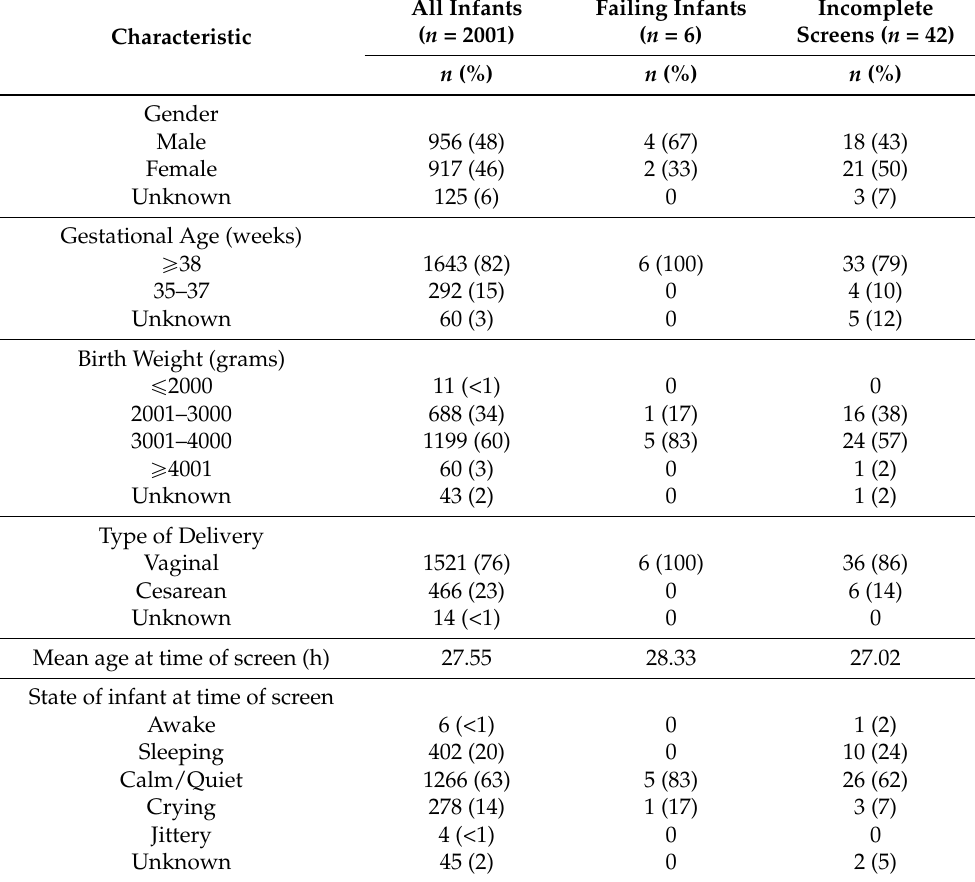
Table 1. Newborn characteristics. Various newborn characteristics were recorded at the time of data acquisition. No correlation was identified between characteristics and the likelihood of a newborn to pass or fail